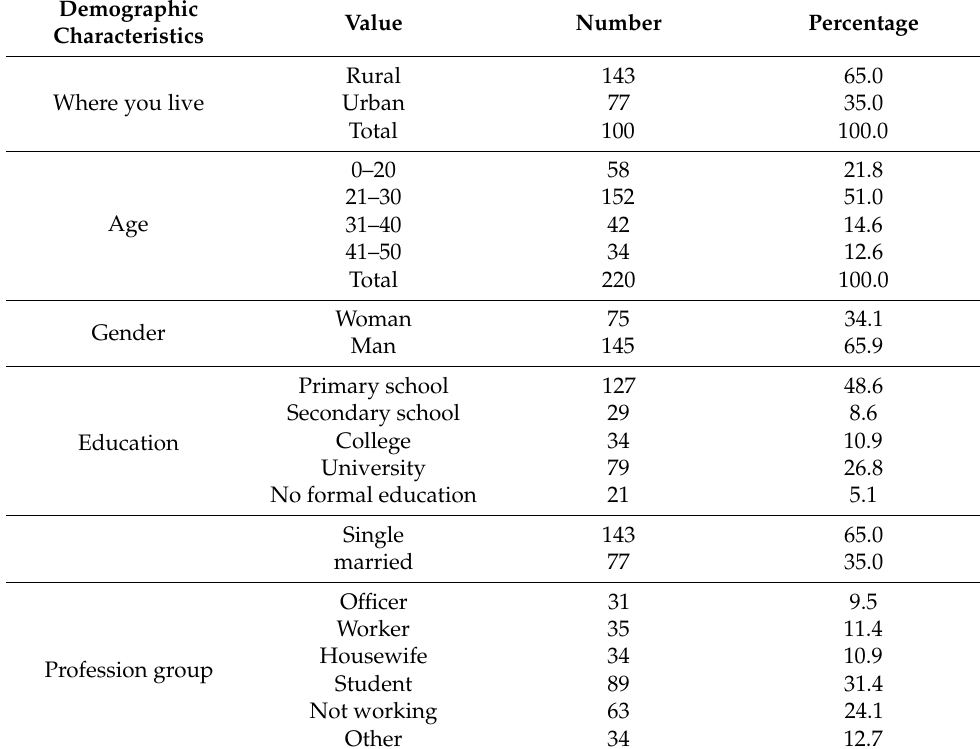
Table 1. Statistic characteristics of the